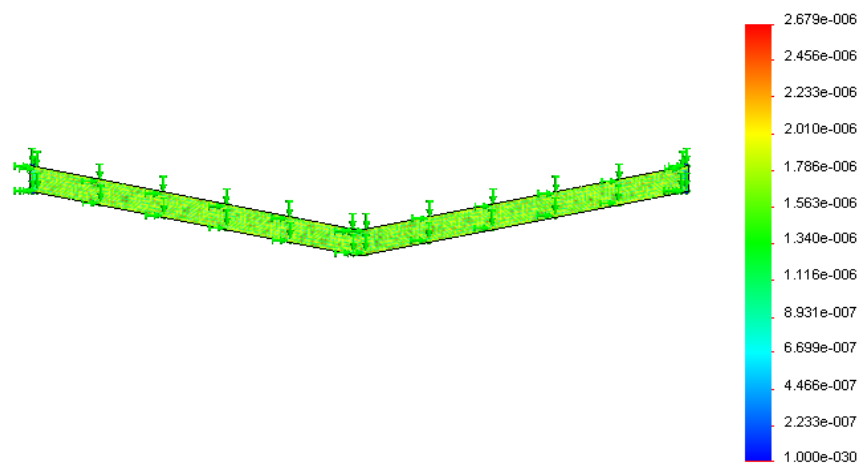
Figure 9. Displacement (in mm) of the silver tracing at 323 K.